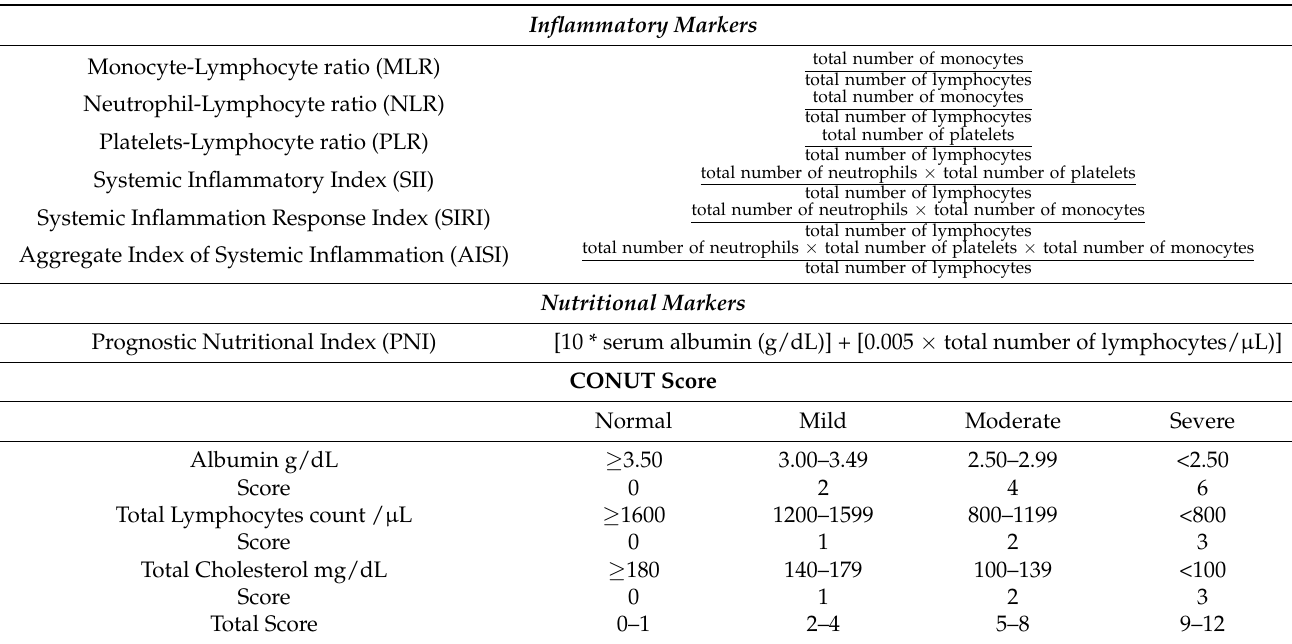
Table 1. Inflammatory and Nutritional Markers utilized in the study. Inflammatory Markers Monocyte-Lymphocyte ratio (MLR) total number of monocytes total number of lymphocytes Neutrophil-Lymphocyte ratio